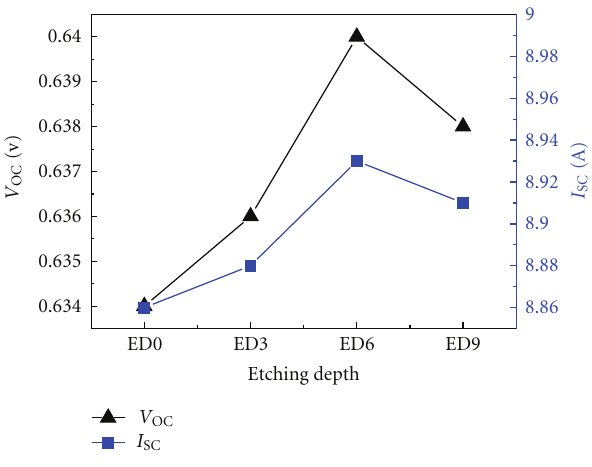
Figure 8: R S and FF of four di ff erent etching depths.